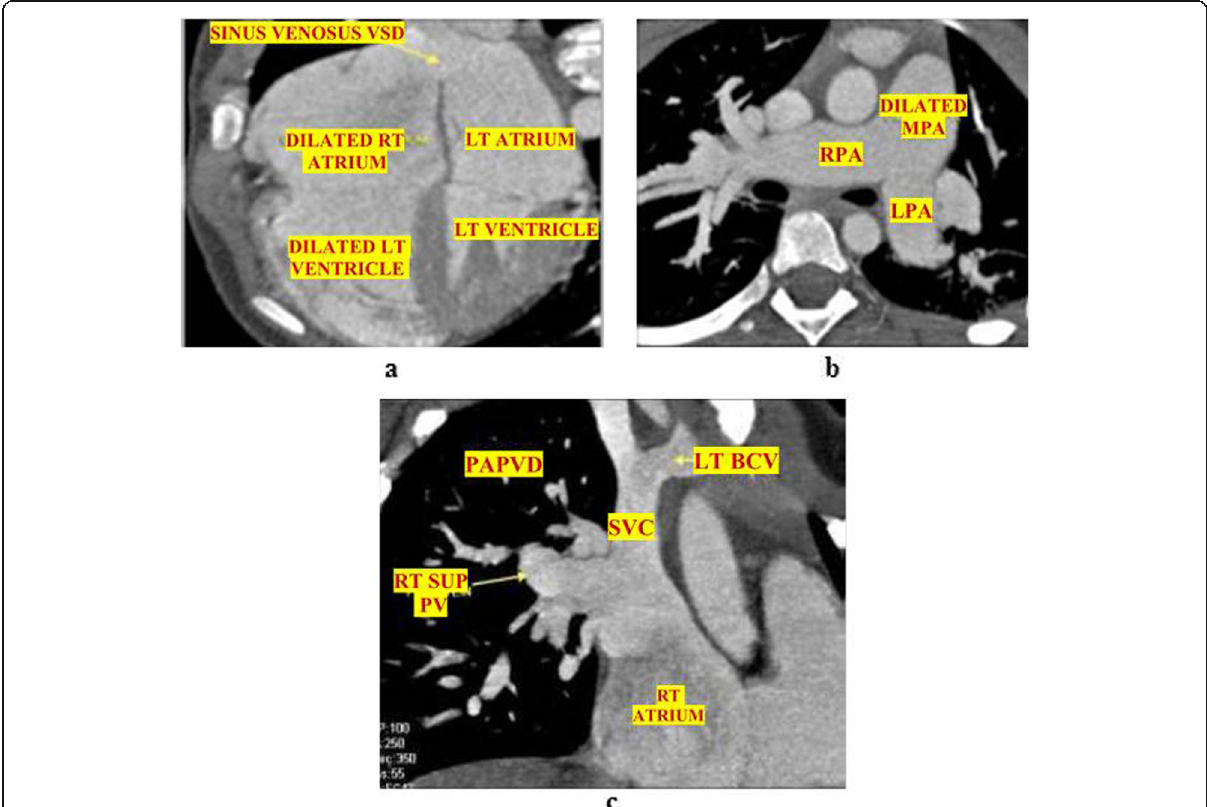
Fig. 3 Nine-year-old female patient with symptoms of right-sided cardiac volume overload and systolic ejection murmur over pulmonary area was noted. ECHO revealed large ASD, dilated both atria and right ventricle, as well as dilated main pulmonary trunk. ECG-gated multi-slice CT angiography of the heart and great vessels confirmed the presence of large sinus venosus ASD, the markedly dilated right atrium and ventricle, the dilated left atrium, and the dilated main pulmonary trunk as well as its main branches on coronal and axial ( a ) and ( b ) MIP images. It also detected the presence of partial anomalous pulmonary venous drainage (right upper pulmonary vein was seen draining into the lower end of the SVC) on reformatted MIP image ( c ), which was not detected by